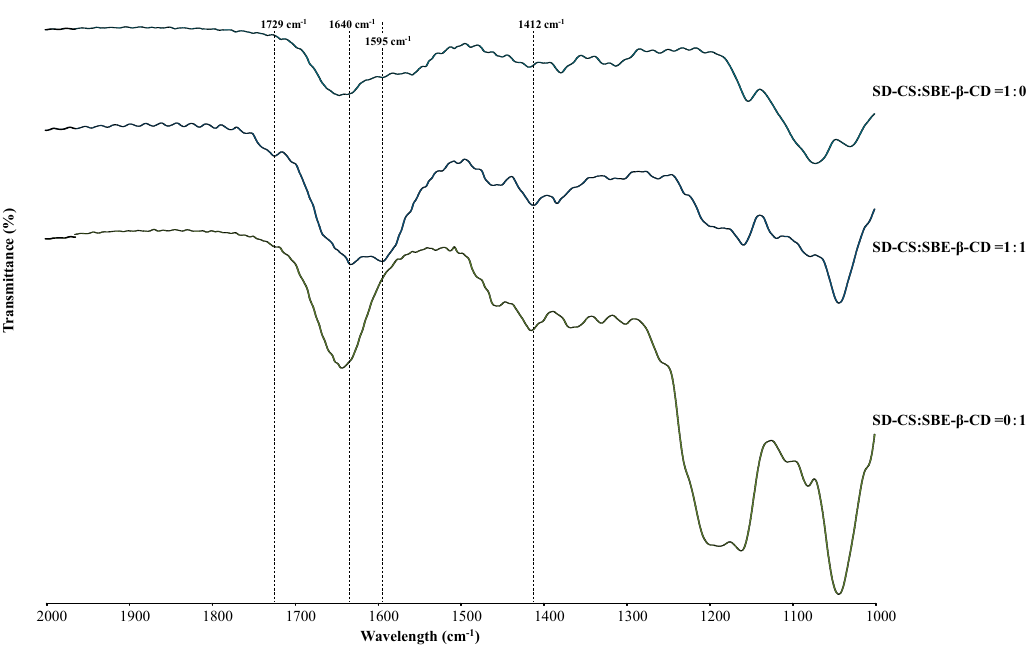
Figure 2. Fourier transform infrared spectroscopy (FT-IR) spectra of spray-dried chitosan (SD-CS), sulfobutyl ether- β -cyclodextrin (SBE- β -CD), and SD-CS/SBE- β -CD components.